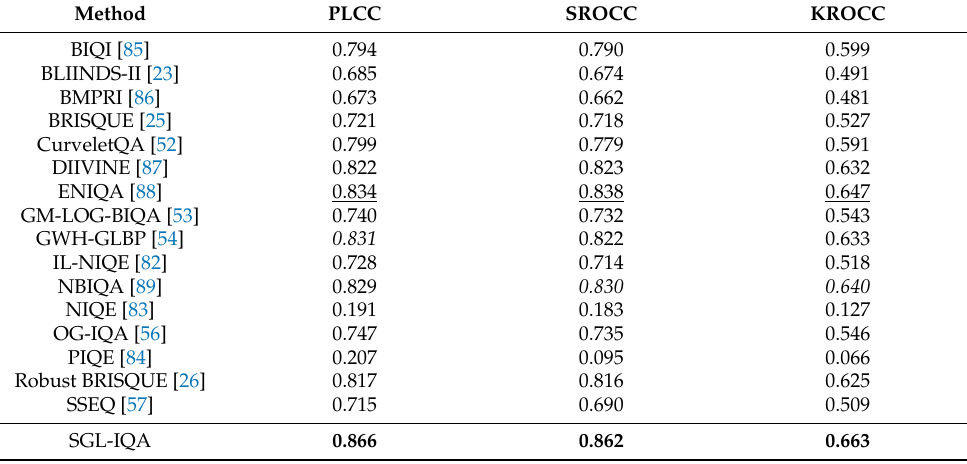
Table 7. Comparison to other state-of-the-art algorithms using GFIQA-20k [18] database. Median PLCC, SROCC, and KROCC values were measured over 100 random train-test splits. The best results are given in bold, the second-best results are underlined, and the third-best results are given in